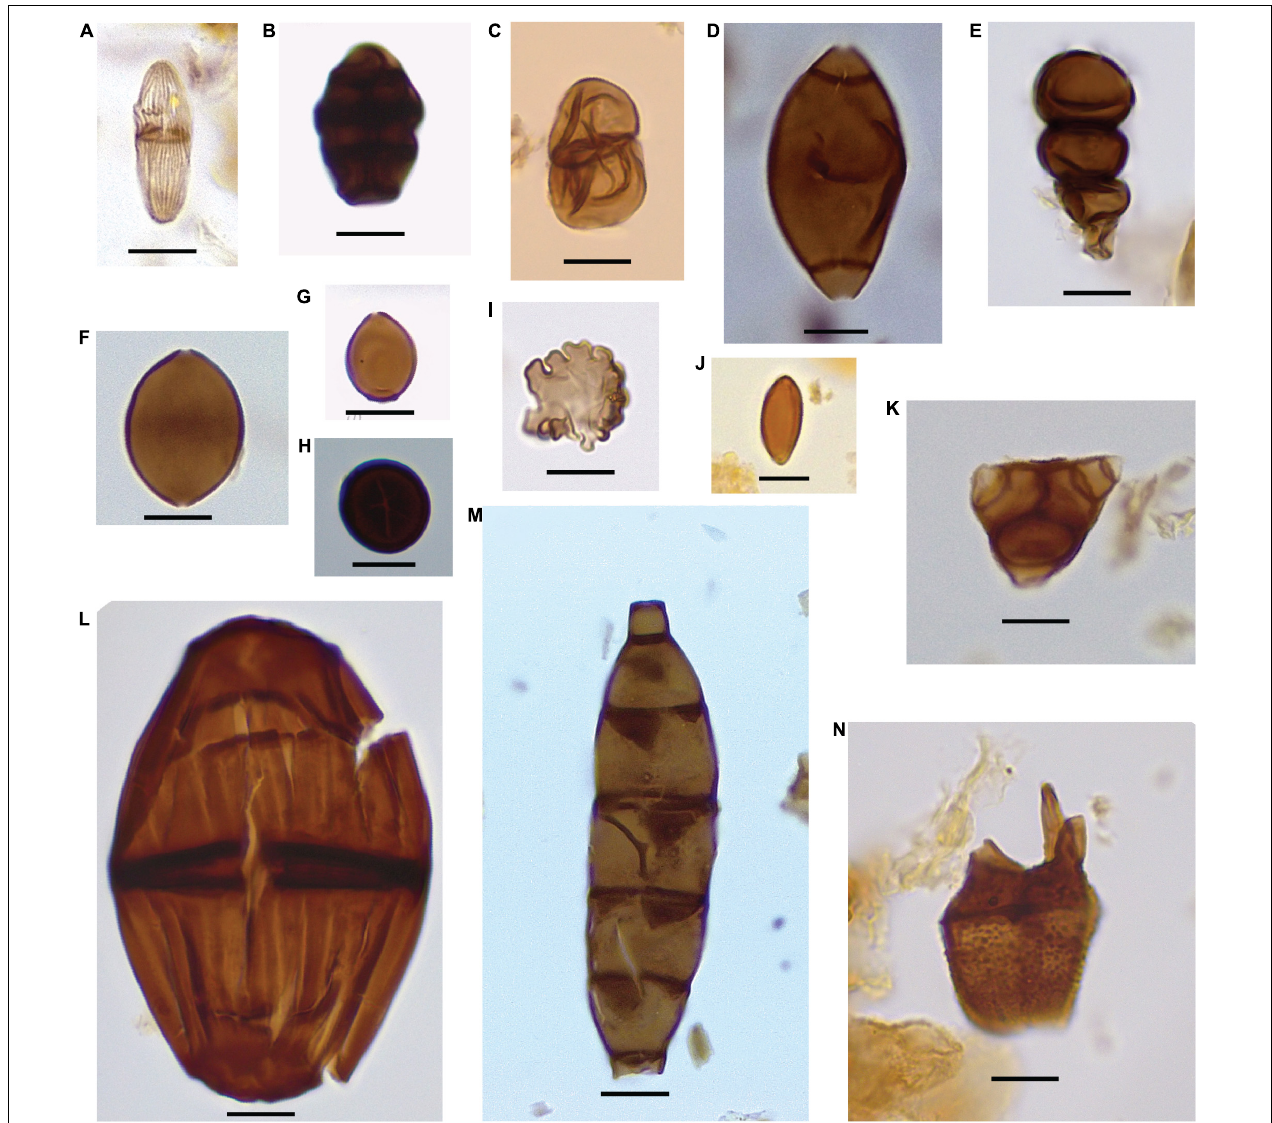
FIGURE 3 | Fungal spores found in Thailand. Each photograph indicates: identification if any, the sample number, morphotype number (OPaL #), and England Finder coordinates (EF). (A) Arecophila sp., sample 457, OPaL 38, EF: N49-3; (B) cf. Canalisporium sp. 2, sample 455, OPaL 140, EF: P26-1; (C) cf. Asterina , samples 453, OPaL 125, EF: Q32-3; (D) Diporotheca , sample 457, OPaL 141, EF: Y35-2; (E) sample 453, OPaL 106, EF: U38-1_T38-3; (F) cf. Chaetomium , sample 457, OPaL 87, EF: N50-2; (G) cf. Cercophora , sample 455, OPaL 92, EF: F24-4; (H) sample 456, OPaL 33, EF: S26; (I) Thyriothecium propagules (Germling), sample 454, OPaL 102, EF: K37-2; (J) sample 453, OPaL 88, EF: G35-2_F35-4; (K) Oncopodiella aff. trigonella, sample 454, OPaL 96, EF: L26-4; (L) Megalohypha aff. aqua-dulces , sample 453, OPaL 97, EF: T37-4; (M) cf. Xylomyces sp., sample 455, OPaL 152, EF: W24-2; (N) Tetraploa, sample454, OPaL 98, EF: AA34. Scale bar: 10 µ m. More information of each specimen in Supplementary Table 1